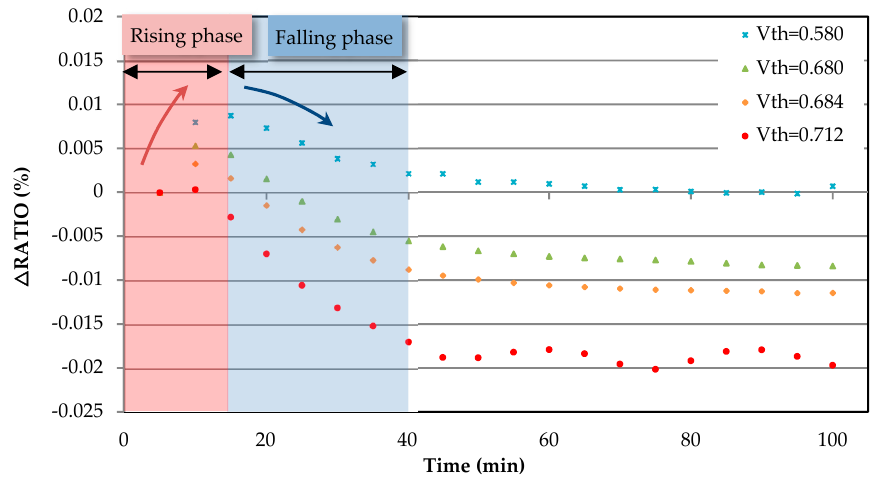
Figure 6. Ratio changes before compensation within 100 min.